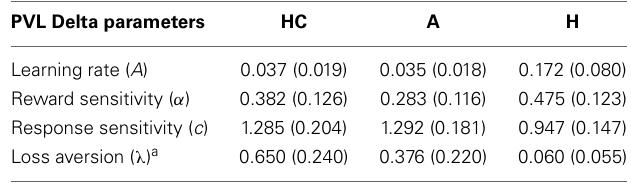
Table 5 | Means and standard deviations (in parentheses) of group mean parameters with the PVL-DecayRI model.